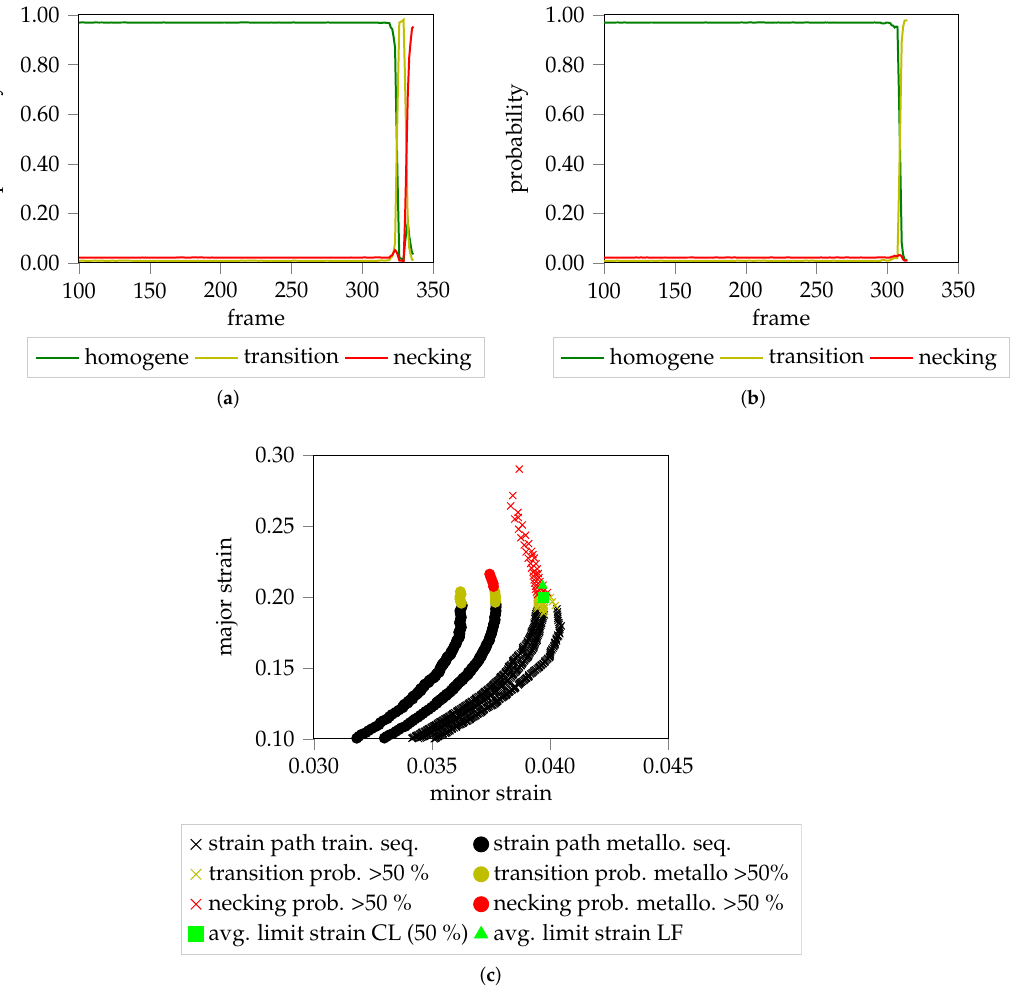
Figure 11. Color coded probability progressions and strain paths of two sequences of DP800-S110 that have not been deformed until fracture in comparison to the strain paths of the training sequences: ( a ) Probability progression of the first trial. All three classes are assigned to the individual frames of the forming sequence. ( b ) Forming of the trial was stopped within transition phase. ( c ) Color coded strain paths of prematurely stopped forming sequences and training sequences. The classified avg. limit strain (CL) is variable depending on the selected probability